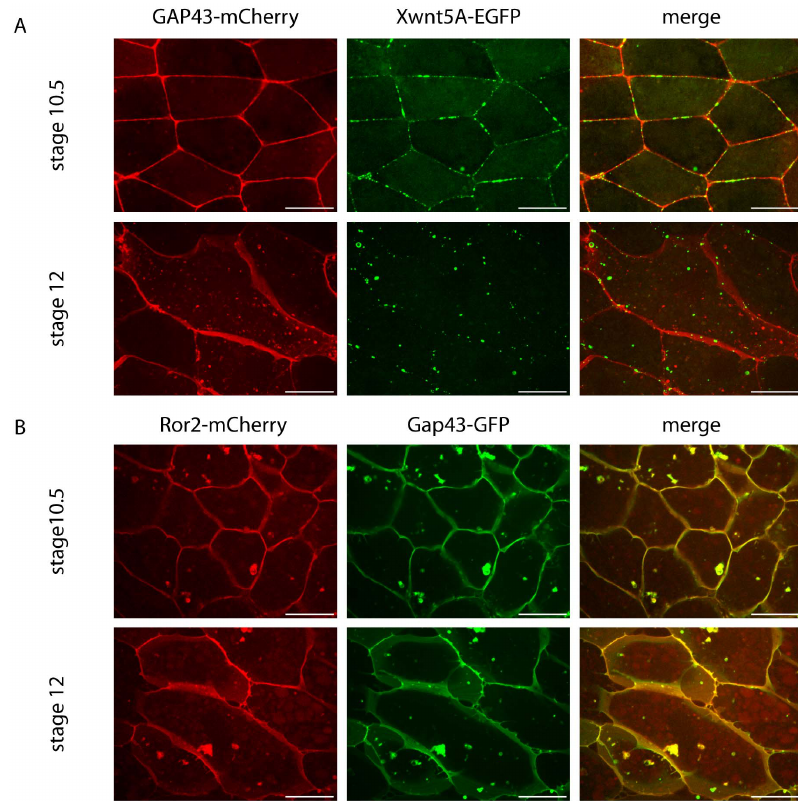
Figure 4. Xwnt5A-EGFP but not ROR2-mCherry clusters in membranes of DMZ cells. A) 150 pg of Xwnt5A-EGFP mRNA were co-injected with 125 pg membrane-anchored (growth-associated protein 43 (Gap43))-mCherry as a lineage tracer in the two dorsal blastomeres of eight-cell stage embryos. At stage 10.25, dorsal marginal zones were explanted and analyzed for subcellular localization of the Xwnt5A-EGFP protein. Prominent Xwnt5A-EGFP clusters localized at the membrane of DMZ cells at the onset (stage 10.5) and end (stage 12) of gastrulation. Shown are snapshots of movies S1 and S2. B) 40 pg ROR2-mCherry were injected into the two dorsal blastomeres of eight-cell stage embryos. ROR2-mCherry is homogenously distributed at the membrane of DMZ explants throughout gastrulation. Shown are snapshots of movies S3 and S4.